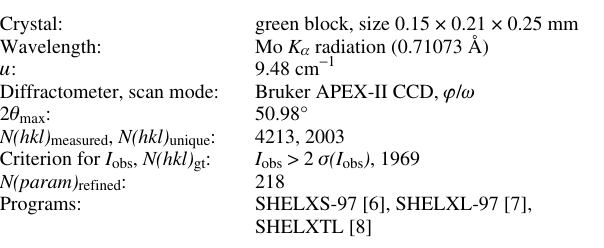
Table 1. Data collection and handling.